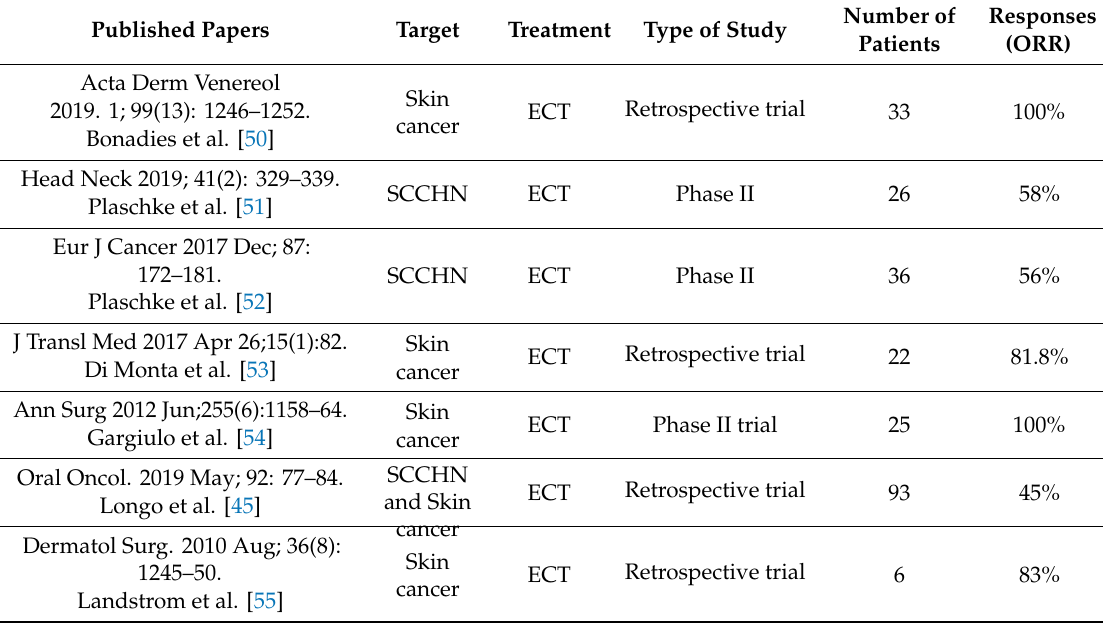
Table 2. Studies enrolling patients with head and neck carcinomas (included primitive skin cancers). Published Papers Target Treatment Type of Study